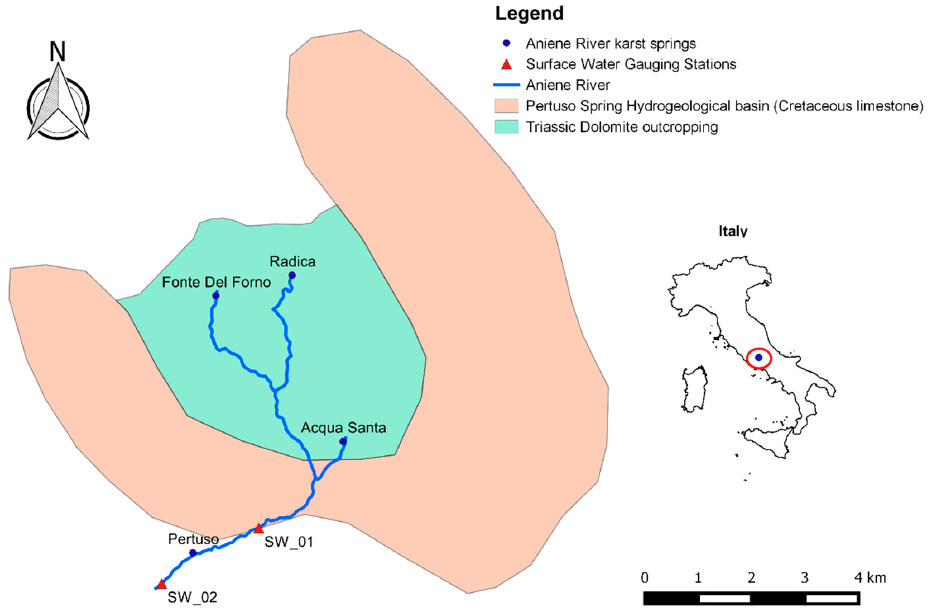
Figure 6. Feeding areas of the main karst springs in the Upper Valley of the Aniene River.